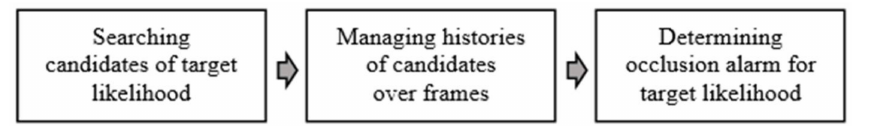
Figure 4. Procedure of target likelihood brightness